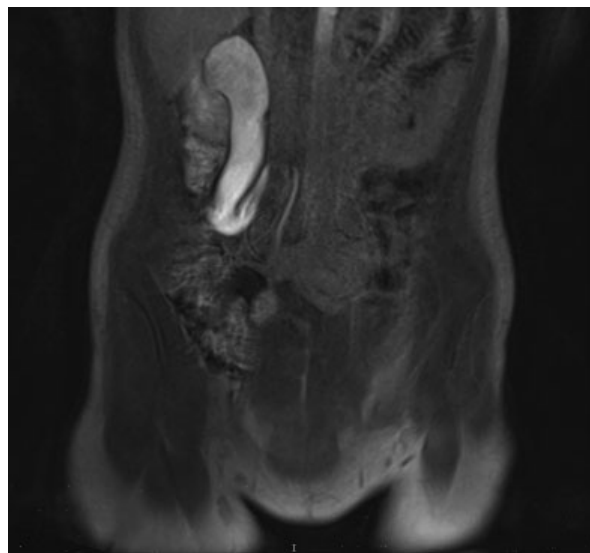
Fig. 1 Coronalviewofthemagneticresonanceimageofthetypicaltype1